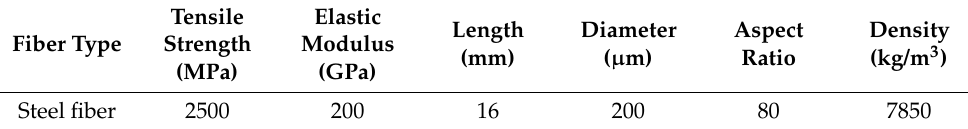
Table 3. Properties of steel fibers [27].